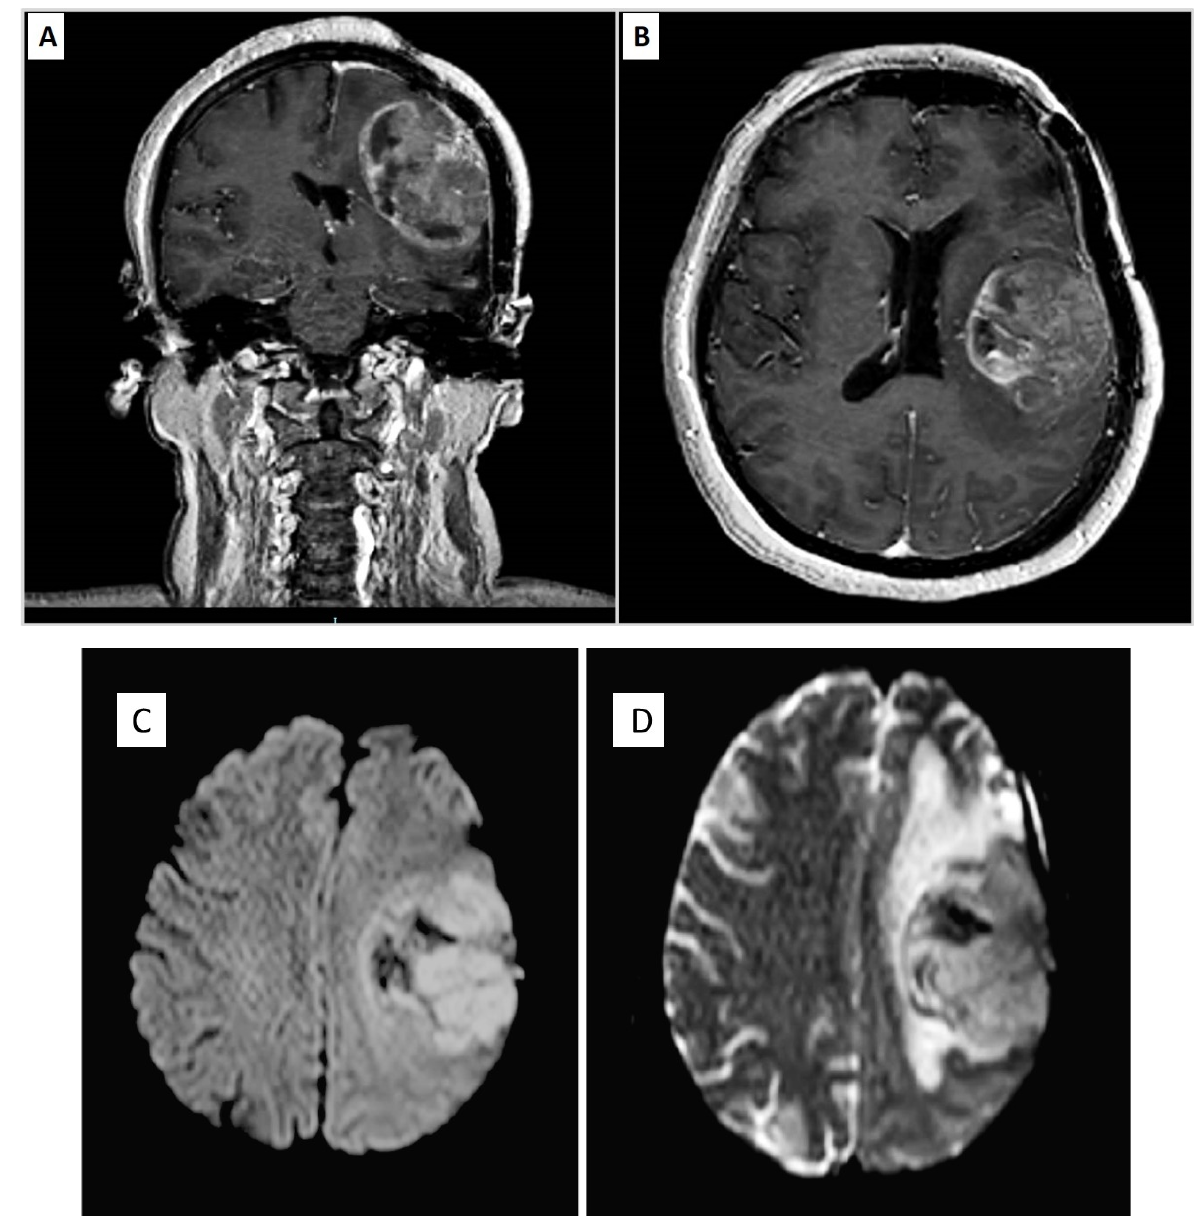
Figure 1. ( A , B ) Axial and coronal projections. Large meningioma in the left parietal area of 5 × 5 cm. The mass is surrounded by perifocal oedema with consecutive compression and dislocation to the right of the ventricular system. The temporal horn of the ipsilateral ventricle results in communication with the subarachnoid space. The administration of the gadolinium determines inhomogeneous accentuation of the mass. ( C , D ) PM displays an heterogenous hyperintensity in DWI surrounded by an hypointense oedema.